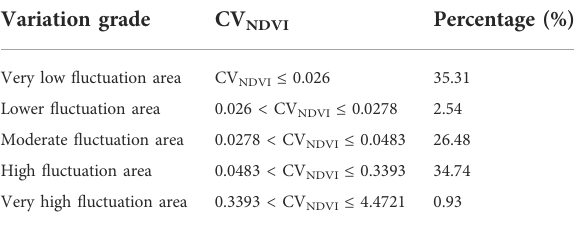
TABLE 4 Variation coef fi cient grade of NDVI in the three northeast provinces.